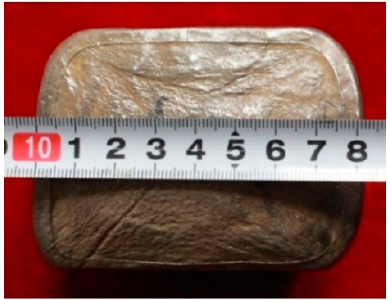
Figure 6. External appearance of Ti-43Al-2Cr-1.5Mn-0.2Y alloy fabricated by MDF with a reduction of 30% per pass.